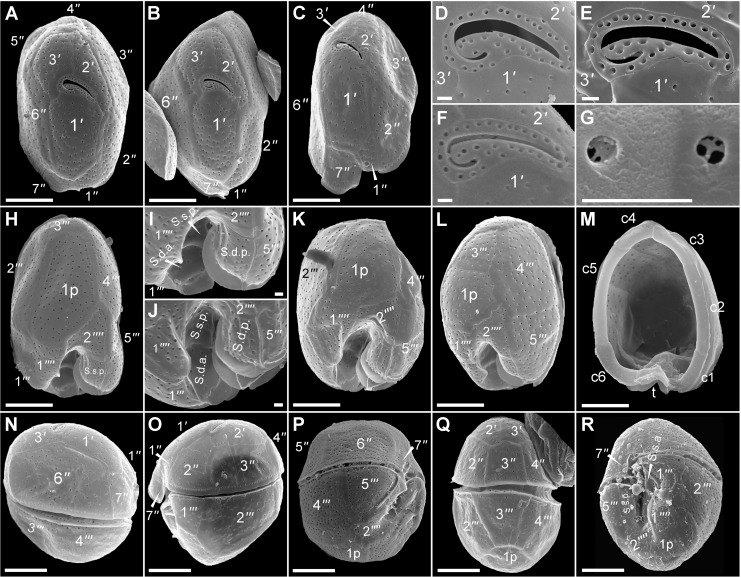
SEM micrographs of Fukuyoa paulensis gen. et sp. nov. (A-C) Apical views.(D-F) Apical pore plate, Po. (G) Detail of the pores. (H-L) Antapical views. (I-J) Detail of the sulcal plates in antapical view. (M) Cingular plates. (N) Right lateral view. (O) Left lateral view. (P) Right ventro-lateral view. (Q) Dorsal view. (R). Ventral view. Scale bar 10 μm, except D-G, I-J, scale bar 1 μm.